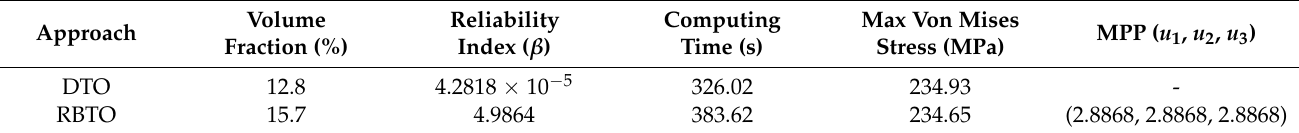
Figure 20. Reliability topology optimization results for 3D L-shaped beam: ( a ) Topological structure; ( b ) Von Mises stress distribution. Table 3. Comparison of topology optimization design